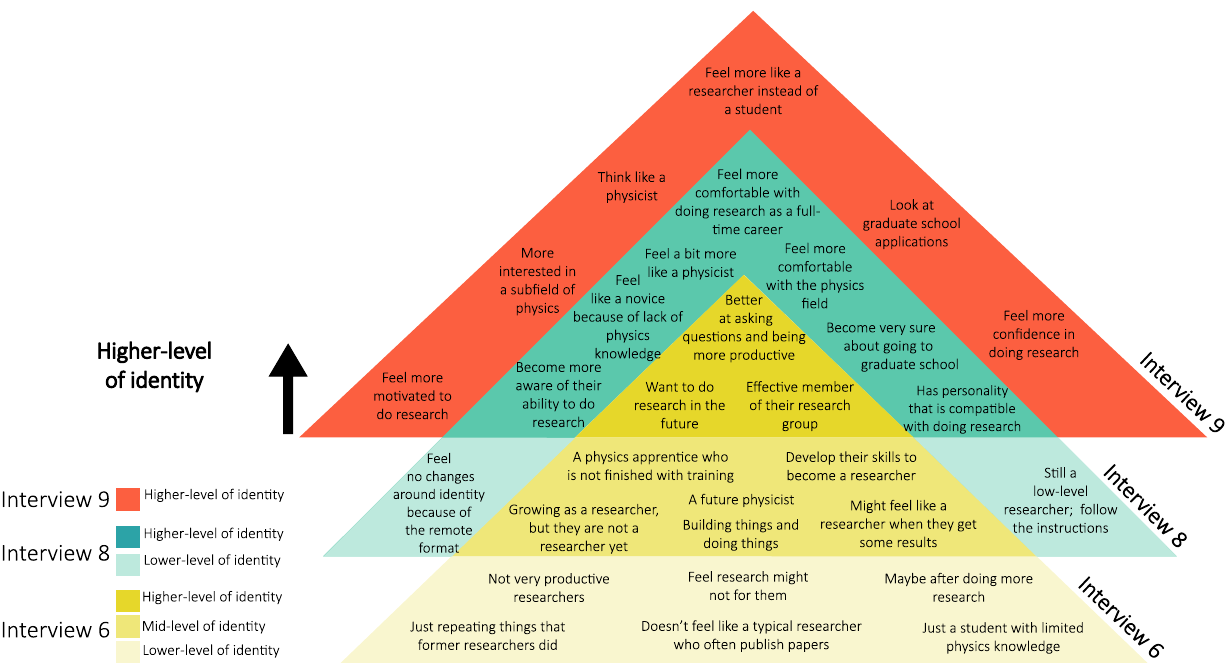
FIG. 4. Process of growth in mentees ’ physics and researcher identity as a function of time. The areas shaded in a lighter color denote the lower level of identity while the areas shaded in a darker color denote the higher level of different shades of color to represent the various level of identity (e.g., lighter shades representing lower level of identity). The text in boxes were paraphrased from mentees ’ quotes.